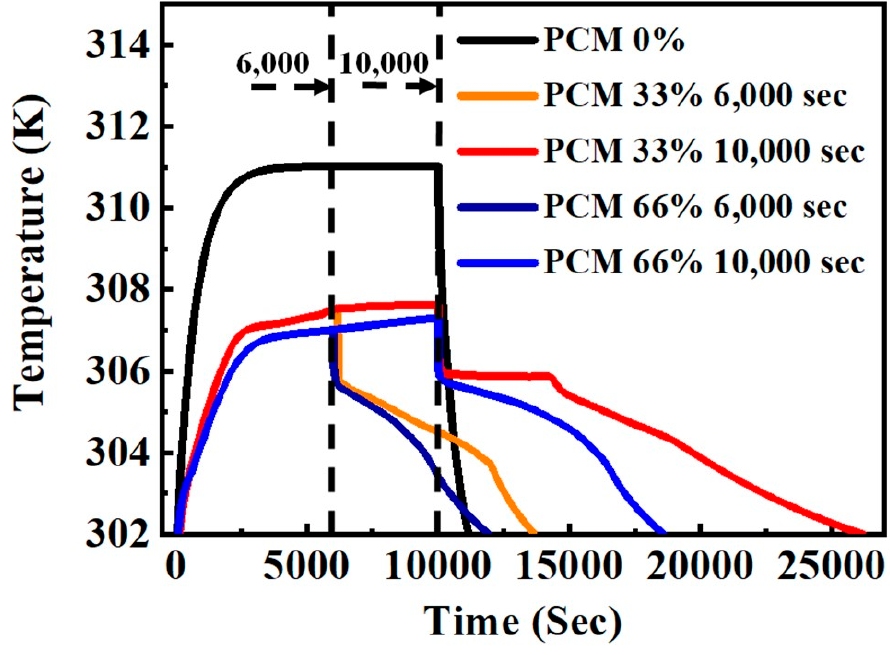
Figure 8. Air temperature change for different PCM quantities during a certain period under the constant solar irradiance of 900 W/m 2 .